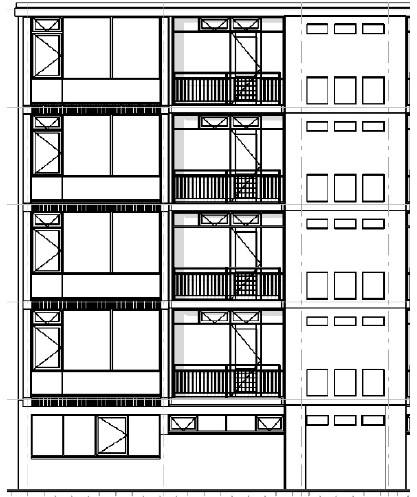
Figure 5. Part of the front (west) façade of the case study building [39].